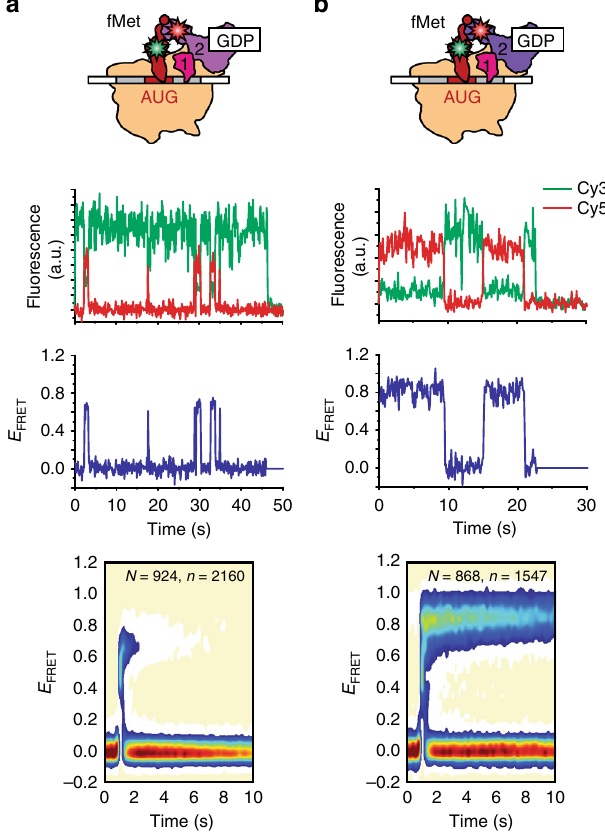
Fig. 2 Effect of substituting GTP with GDP. smFRET measurements of ( a ) wtIF2(GDP) and ( b ) mutIF2(GDP) interacting with 30S IC wD and 30S IC mD , respectively. Data are displayed as in Fig.